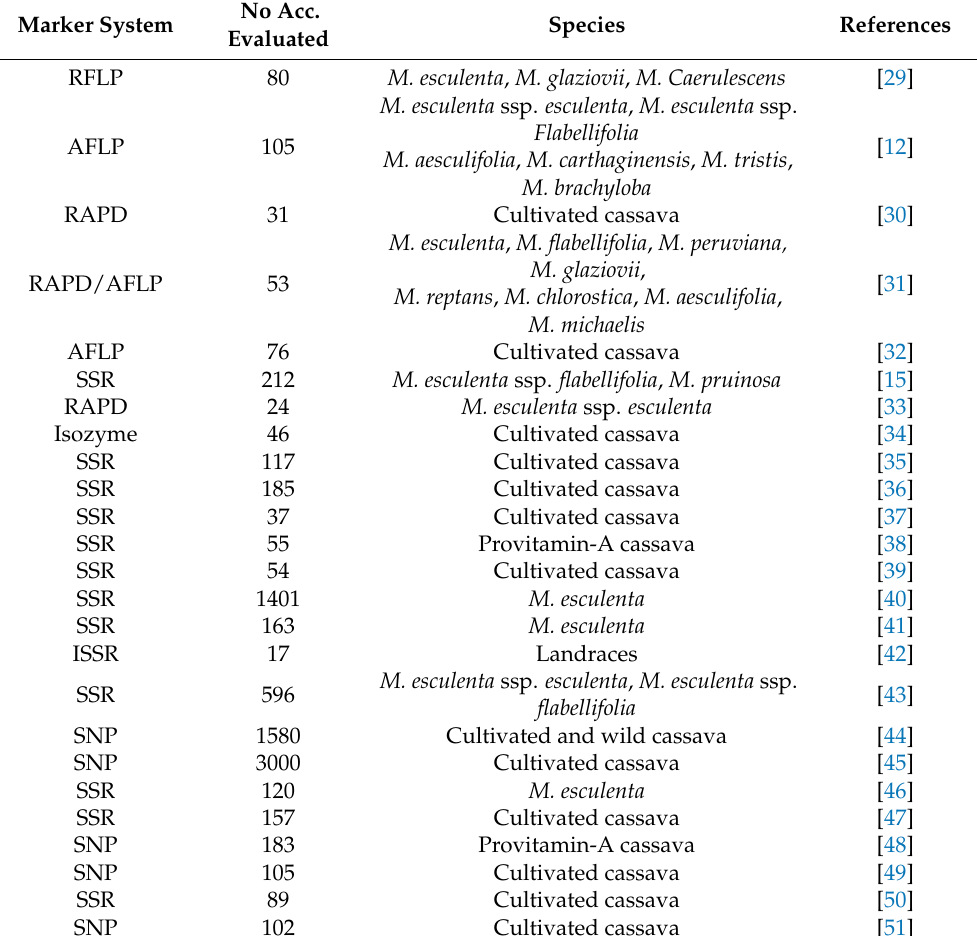
Table 1. Genetic diversity analyses studies reported in cassava. No Marker System